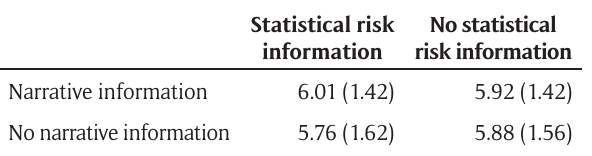
Table 3: Mean scores ( SD ) on HPV-vaccination intention (1–7; N =